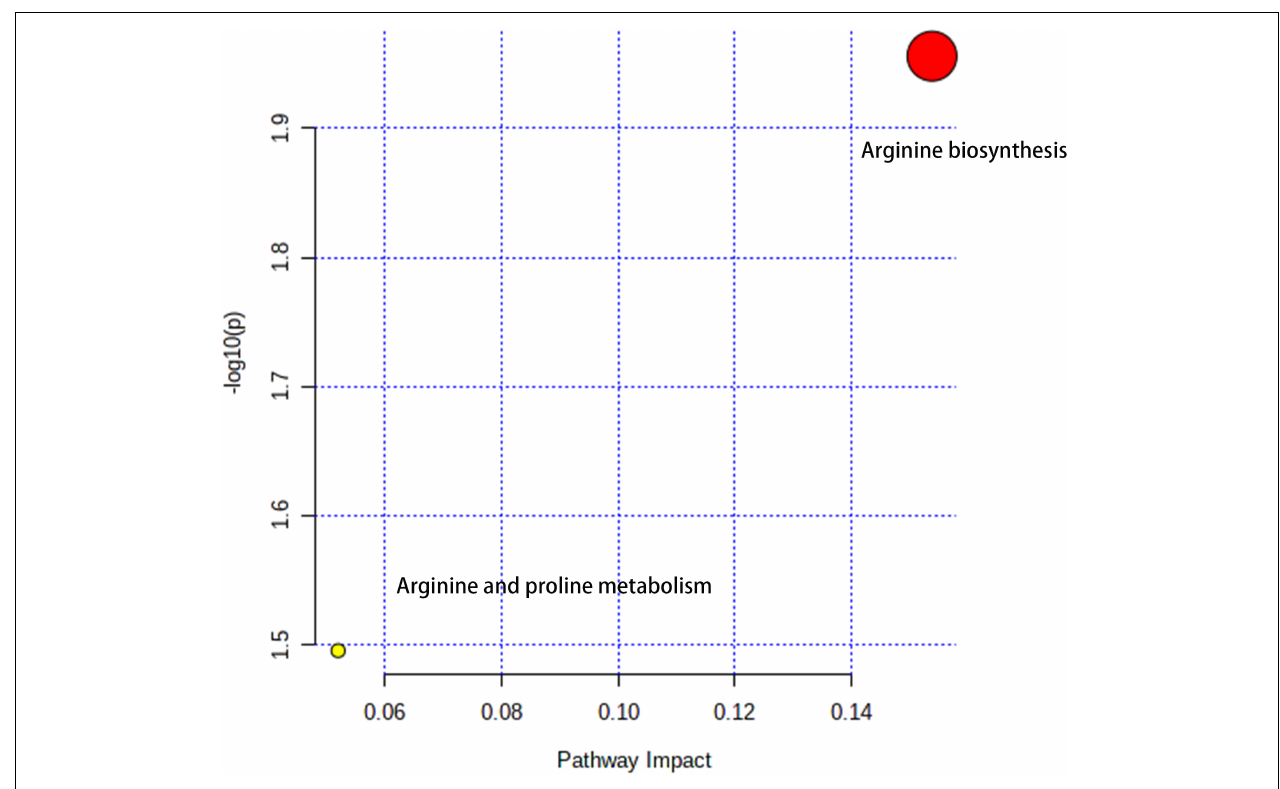
FIGURE 7 | Enrichment reports of metabolic pathways in core